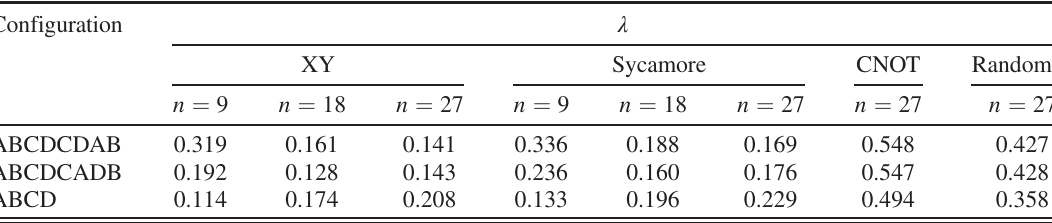
TABLE IV. Effective eigenvalue λ for different configurations, gates (XY, Sycamore, CNOT, and random), and system sizes n in a 2D geometry (Fig. 17). With random a , we denote the gate with randomly generated canonical